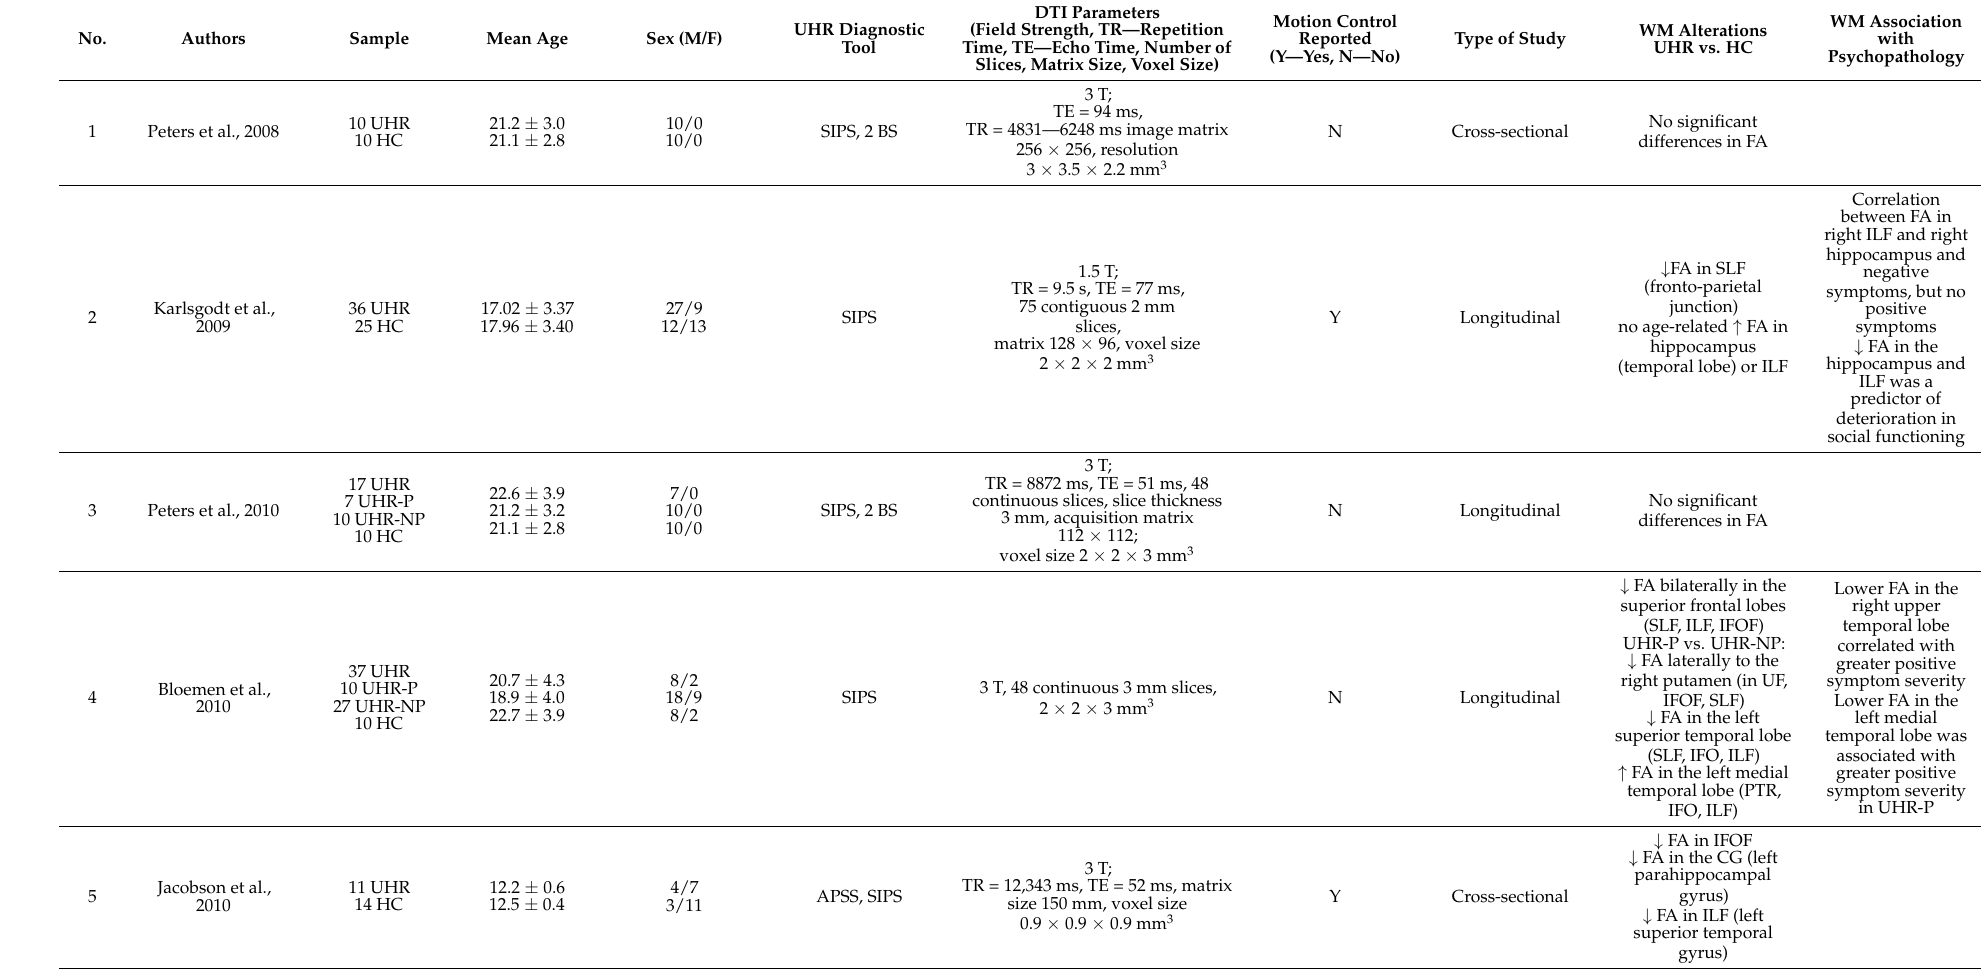
Table 1. Search results of changes in diffusion parameters in the ultra-high-risk psychosis